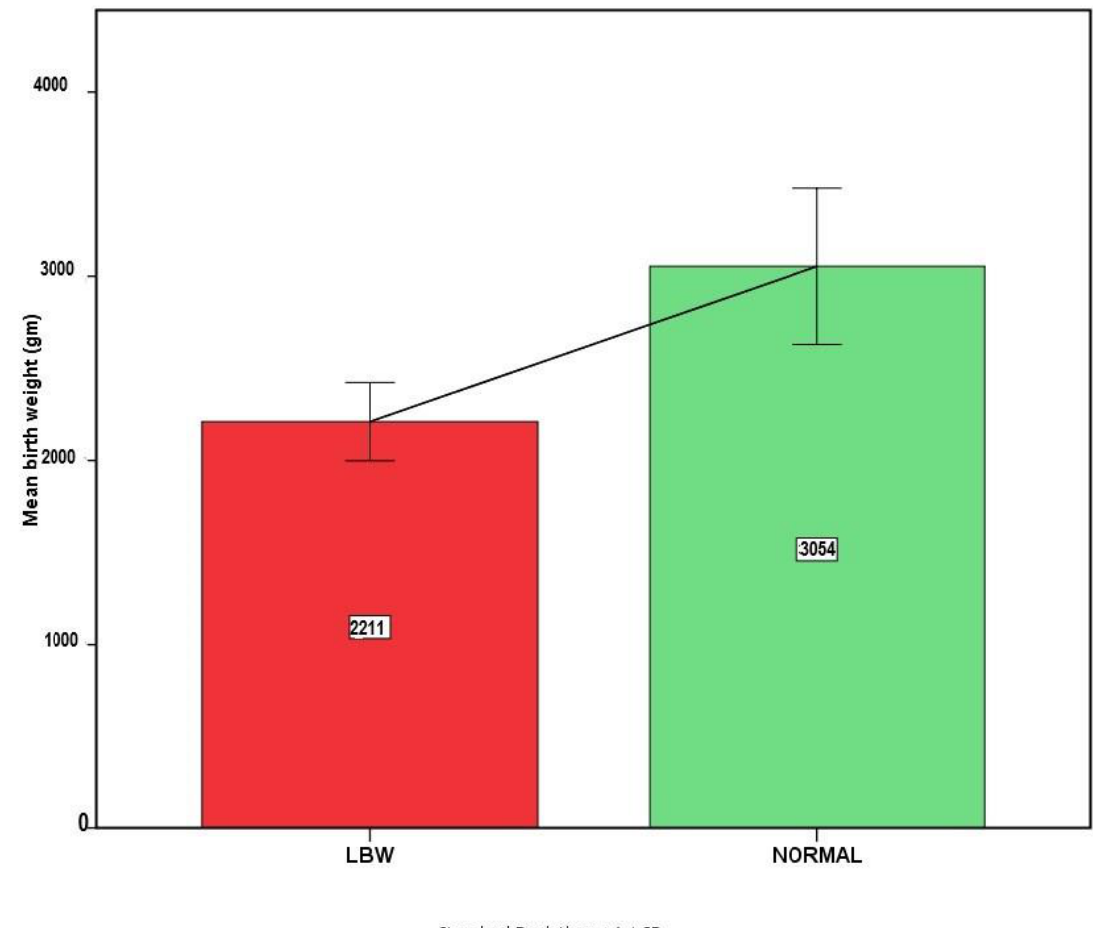
Figure 2. Status of birth weights among